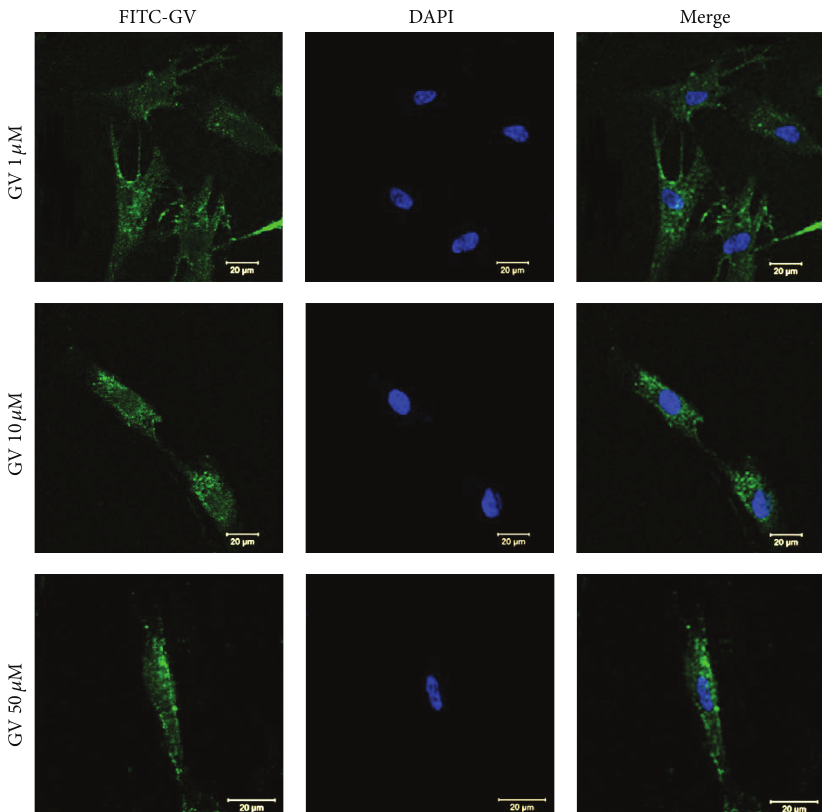
Figure 1: Internalization of various GV1001 concentration by hDPCs. 1, 10, and 50 𝜇 M GV1001 peptides labeled with FITC at the C-terminus (GV1001-F) were used to treat hDPCs as described in Section 2. Internalization of the peptides was analyzed by confocal